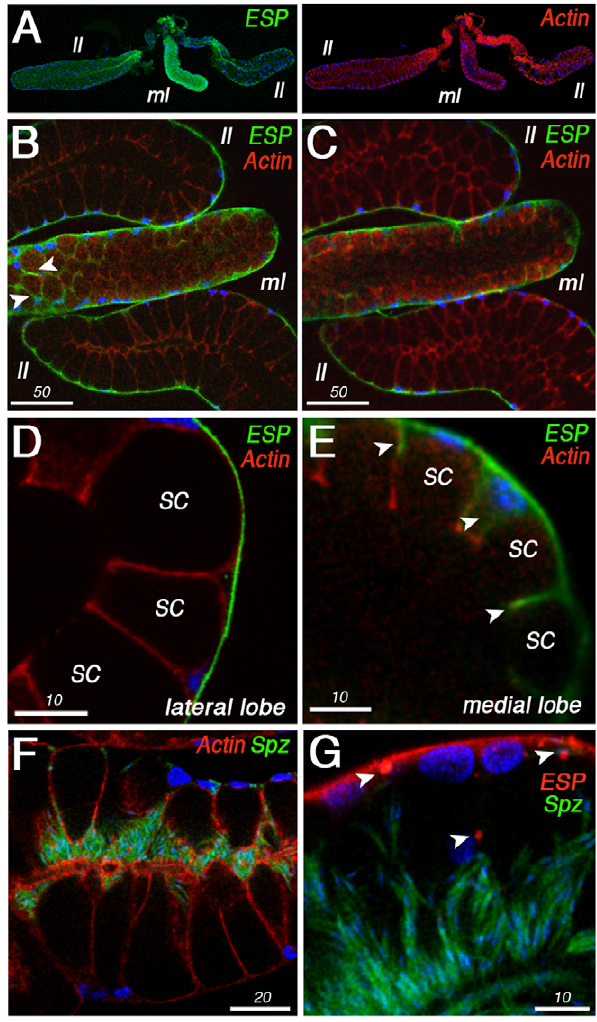
Figure 5. AgESP immunolocalization in Anopheles gambiae salivary glands (SGs). (A) AgESP is expressed in the distal region of the lateral lobes (ll) and medial lobes (ml), with a stronger staining in the medial lobe. AgESP protein (green) in the left panel and actin (red) in the right panel. (B, C) AgESP protein is expressed on the basal side of the distal lobes of the SG lobes. (D) In the lateral lobes, AgESP is only present on the basal surface of the epithelial cells lining the secretory cavities (SC). (E) In the medial lobes, AgESP is also present in the cytoplasm of epithelial cells as indicated by the white arrowheads in (B) and (E). (F) Actin staining in red and sporozoites, GFP in green, in P. berghei -infected SGs 18 days post feeding (PF). (G) Localization of ESP in red and sporozoites, GFP in green, in P. berghei -infected SGs (18 days PF). White arrowheads indicate the presence of ESP aggregates in infected SGs.